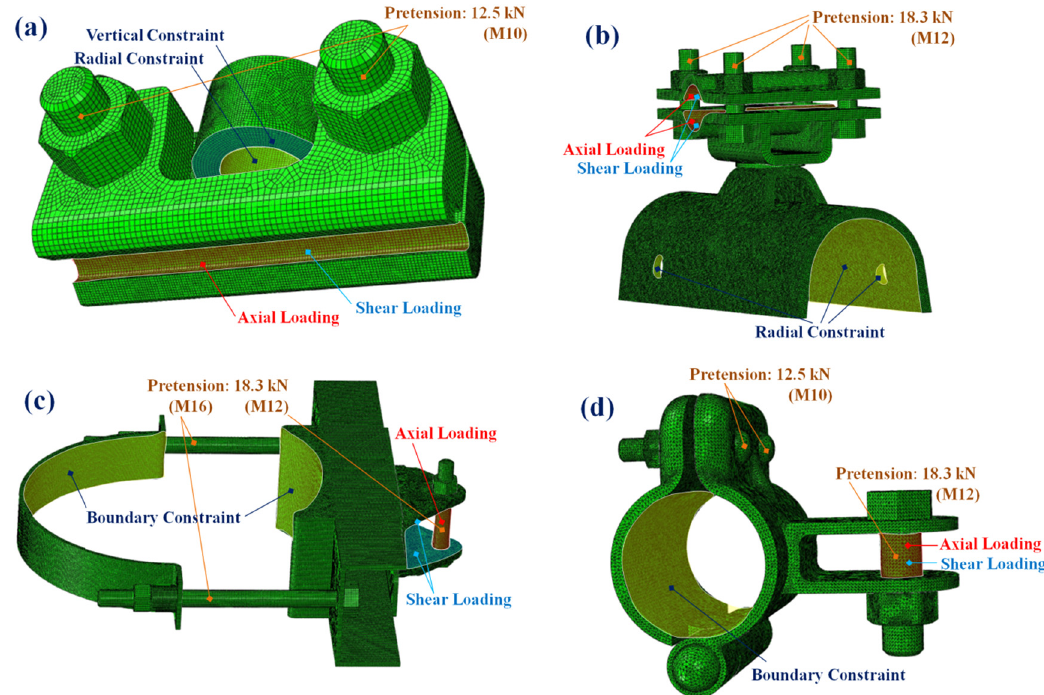
Figure 14: Detailed FE model of connection components. ( a ) Contact clamp; ( b ) messenger clamp; ( c ) support base; ( d ) bushing